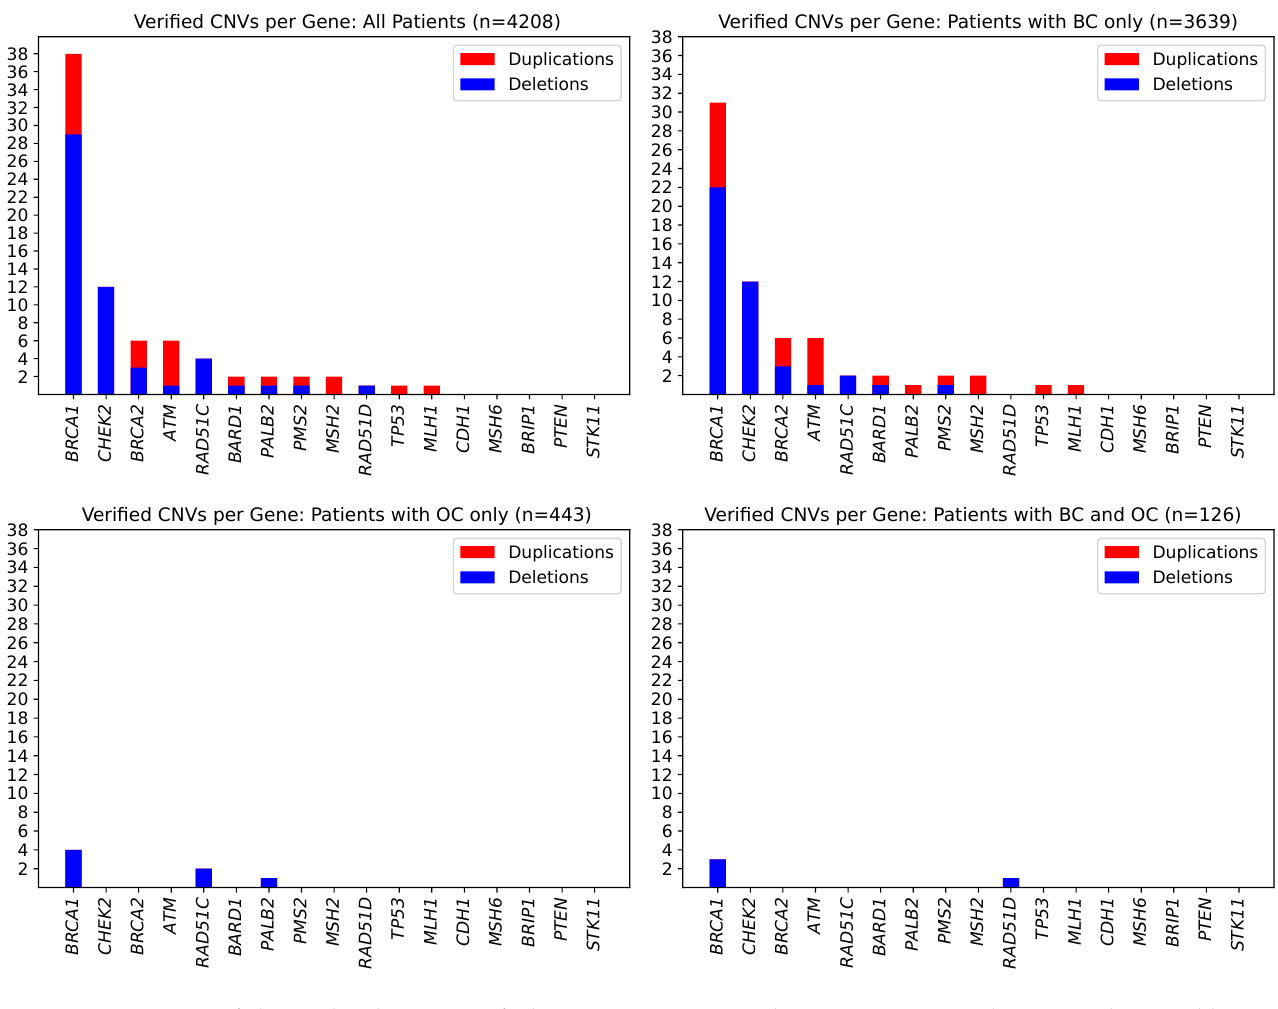
Figure 1. Counts of observed and MLPA-verified CNVs in 17 cancer predispositions genes. Deletions are shown in blue, and duplications are shown in red. Seventy-seven CNVs could be confirmed affecting 76 patients. (Upper left) Overall study sample of 4208 individuals. (Upper right) For the subgroup of 3639 individuals affected by BC. (Lower left) For the subgroup of 443 individuals affected by OC. (Lower right) For the subgroup of 126 individuals affected by